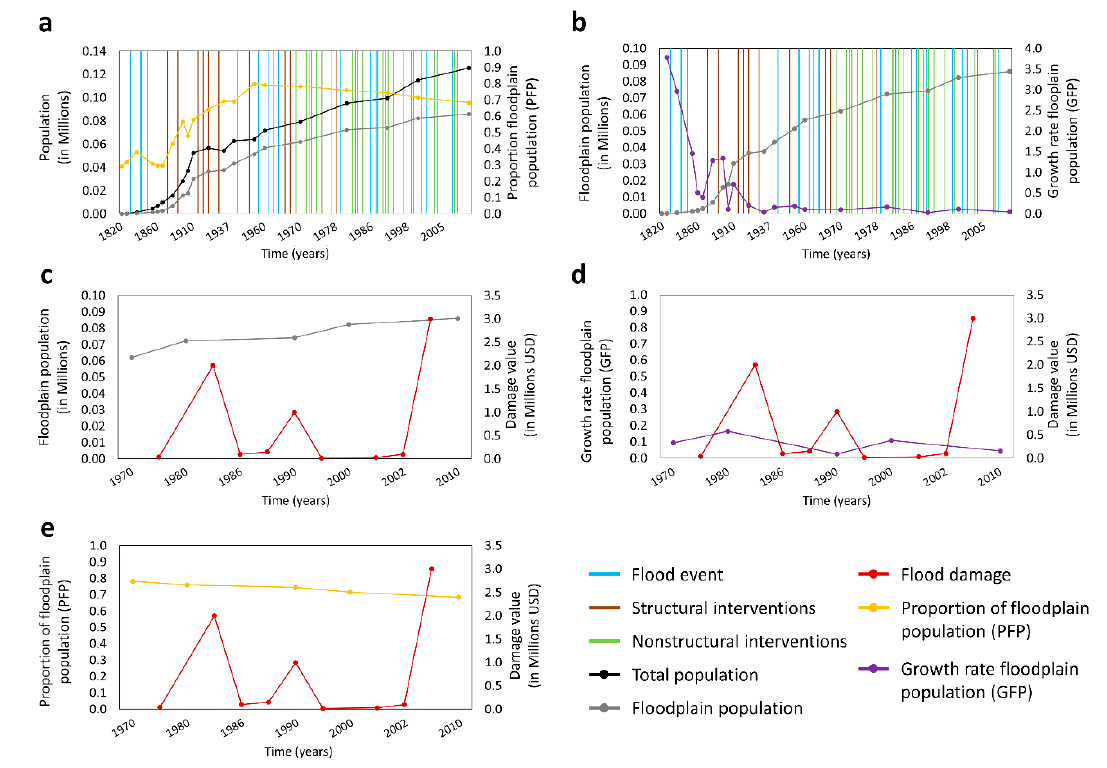
Figure 7. Time-series of floodplain population dynamics, flood events, and related adaptation measures in Sebastian county. ( a ) Total state population, floodplain population, proportion of floodplain population, occurrence of flood events, and structural and nonstructural interventions; ( b ) floodplain population, floodplain population growth rate, occurrence of flood events, and structural and nonstructural interventions; ( c – e ) flood damages (in thousand USD), floodplain population, floodplain population growth rate, and proportion of floodplain population.